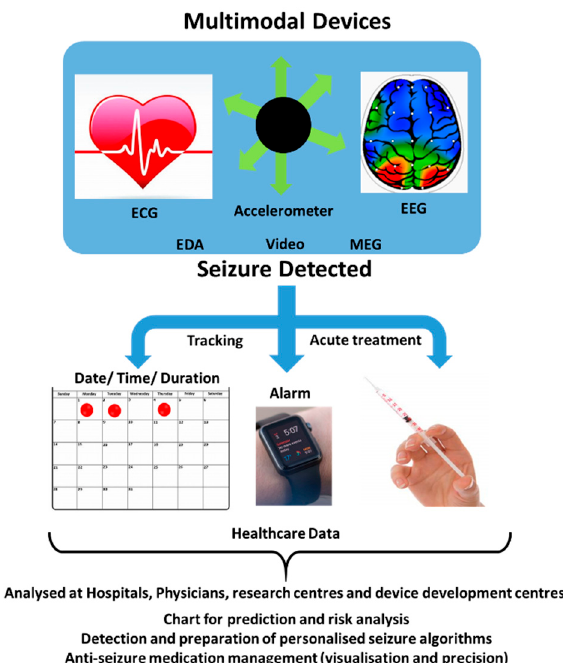
Figure 9. Utilization of a multimodal system for charting and seizure prediction for PoC application.